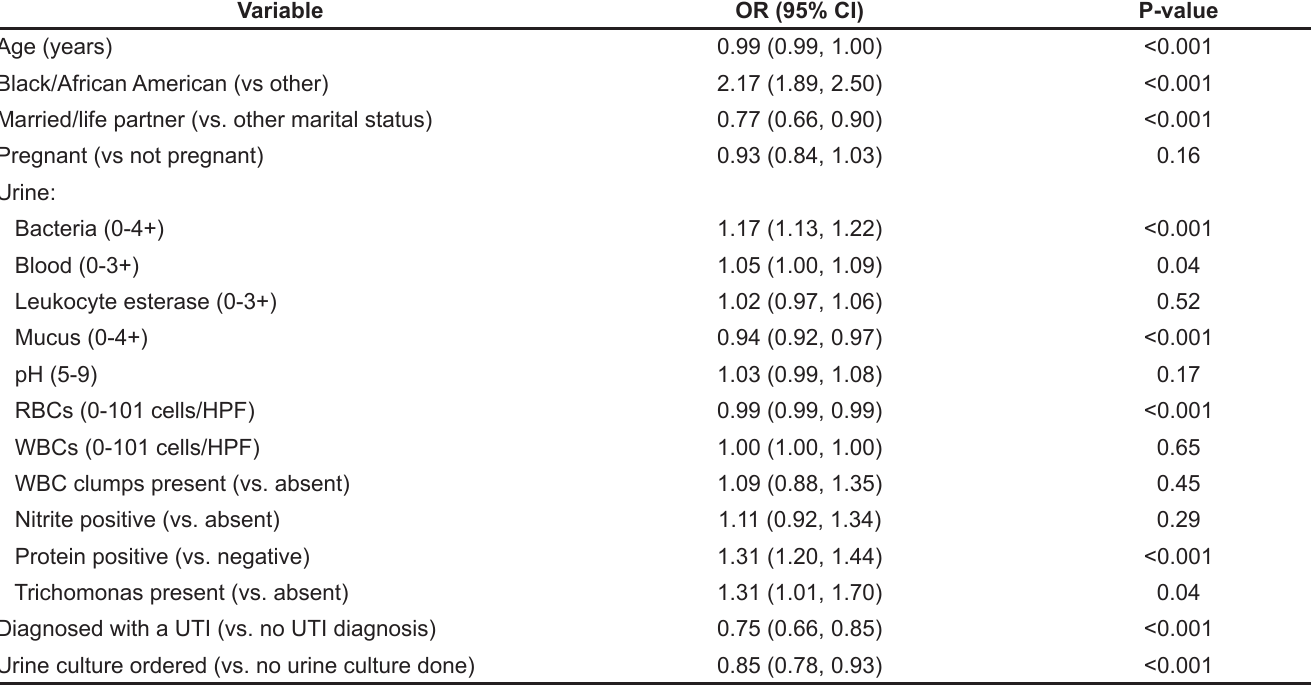
OR , odds ratio; CI , confidence interval; RBCs , red blood cells; HPF , high powered field; WBCs , white blood cells; UTI , urinary tract